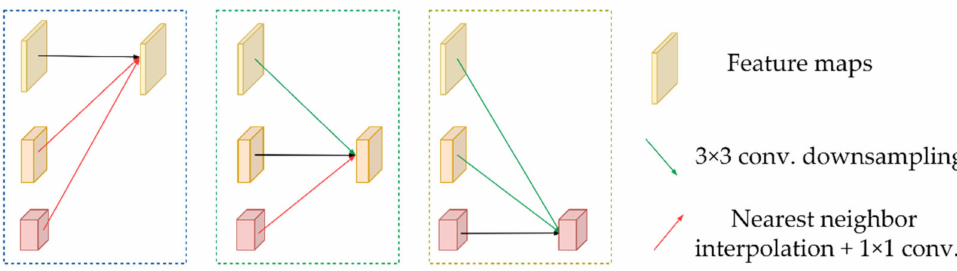
Figure 6. Up sampling and down sampling methods.